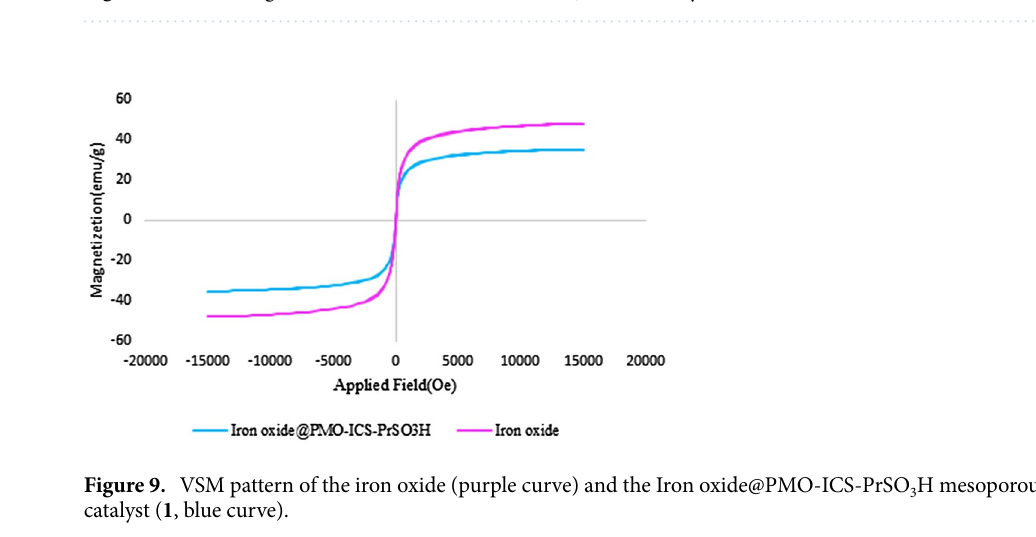
Figure 8. TEM images of Iron oxide@PMO-ICS-PrSO 3 H nanocatalyst ( 1 ).